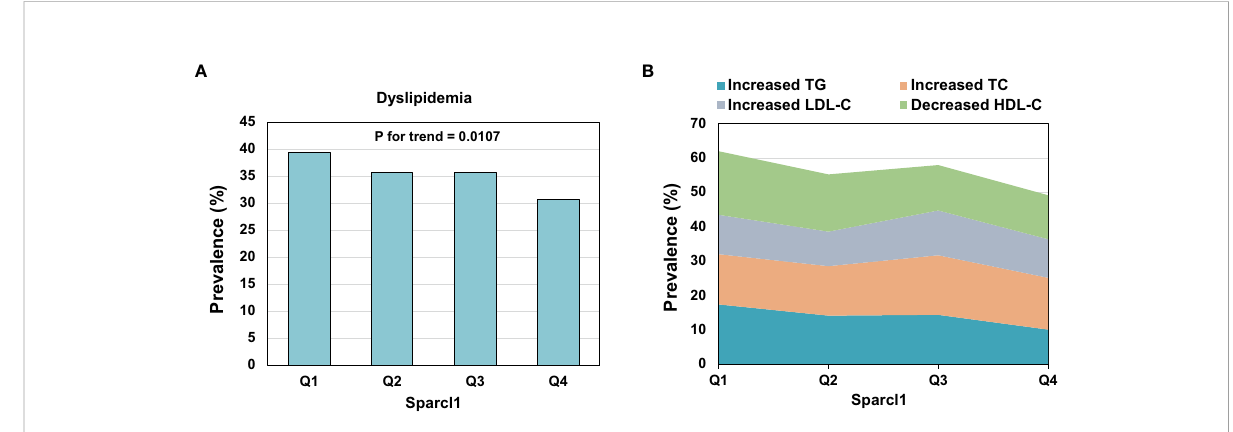
FIGURE 1 Prevalence of dyslipidemia (A) and individual components (B) according to the quartiles of serum Sparcl1. TG, triglyceride; TC, total cholesterol; LDL-C, low-density lipoprotein cholesterol; HDL-C, high-density lipoprotein